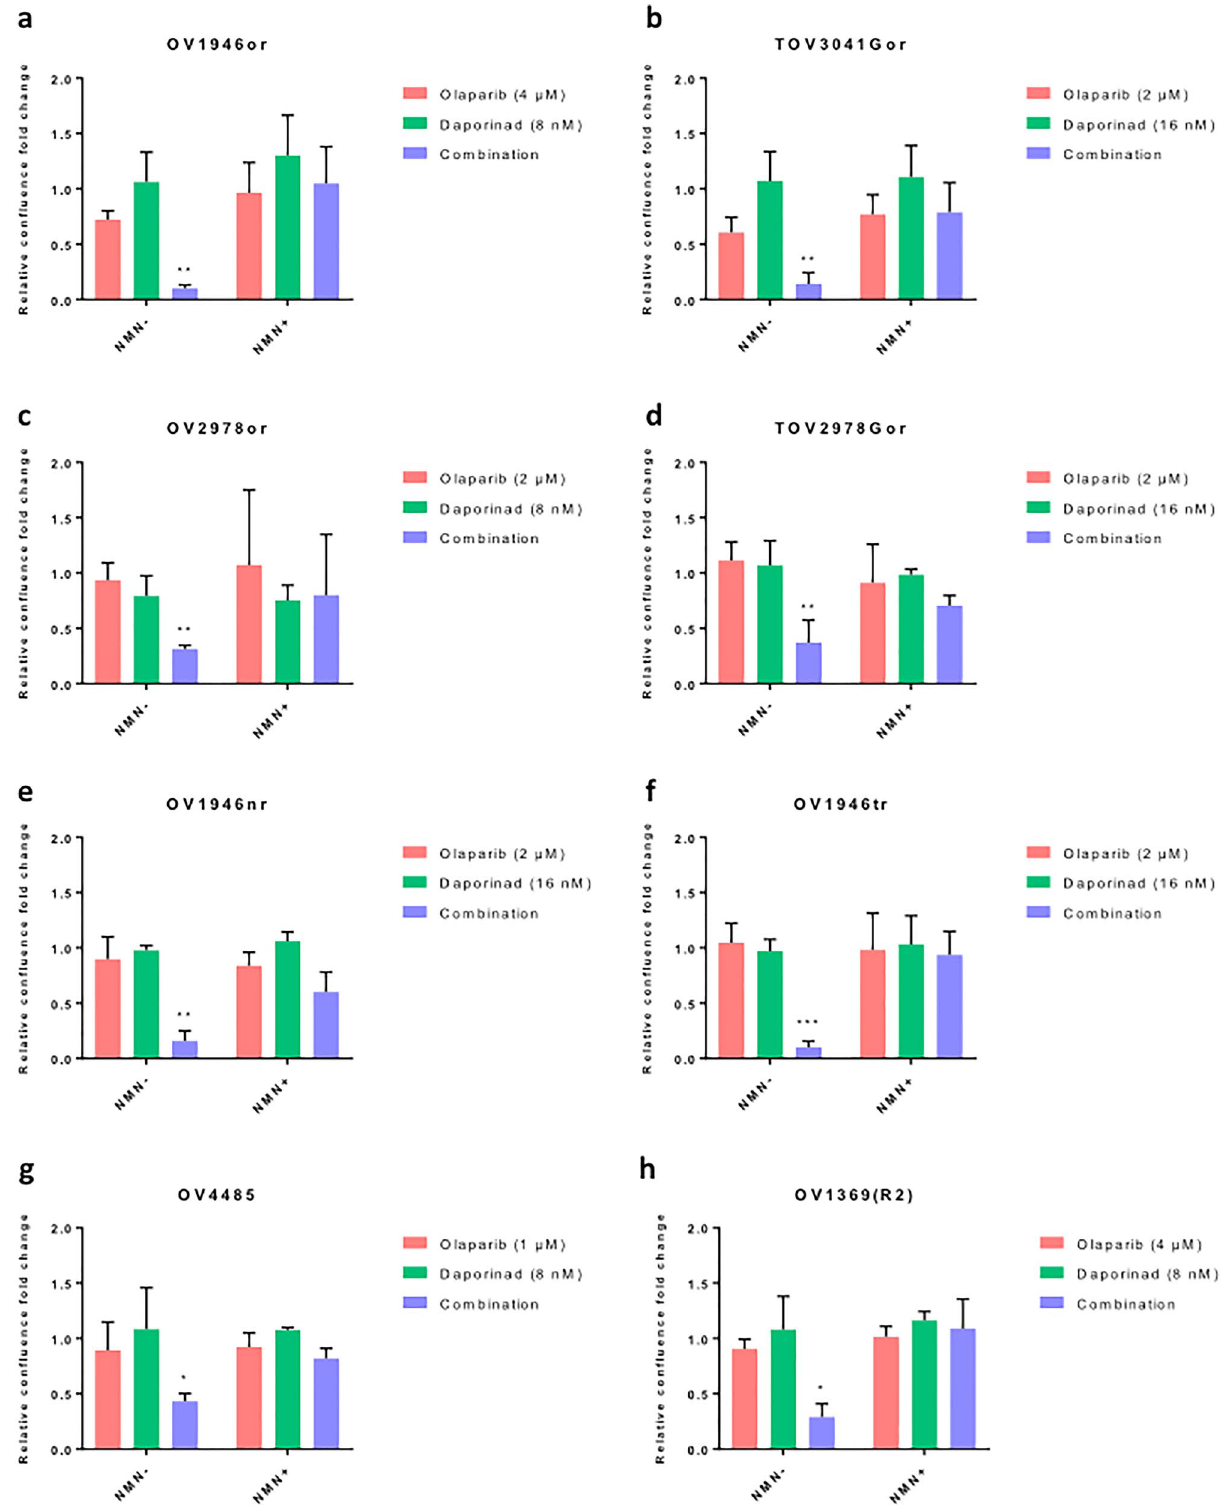
Figure 2. Combination of daporinad and olaparib in various resistant cell lines. Bar graphs comparing the relative confluence fold change at cell proliferation experiment end points after treatment with daporinad, olaparib or a combination of the two, in absence or presence of NMN. Experiments were repeated three times. Error bars represent SEM. Statistical significance was determined using Student’s t tests between the combination and each single agent, and only the highest p-value was illustrated. *p < 0.05, **p < 0.01, ***p < 0.001. Numerical values are detailed in Supplementary Figs. 2 and